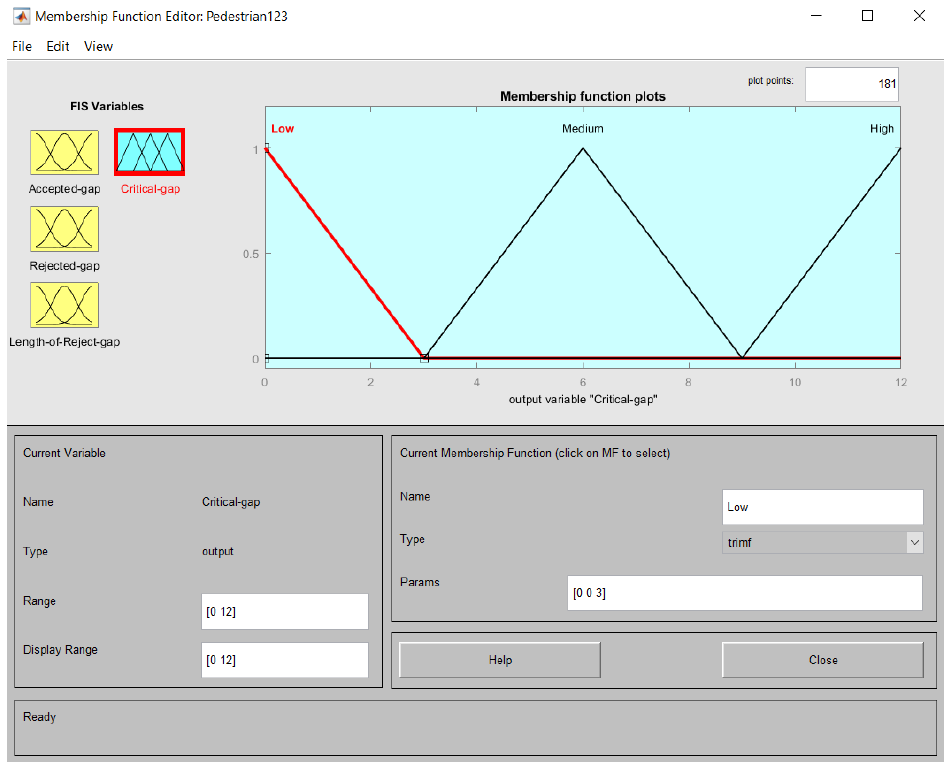
Figure 6. Low, medium, and high ranges for outputs.